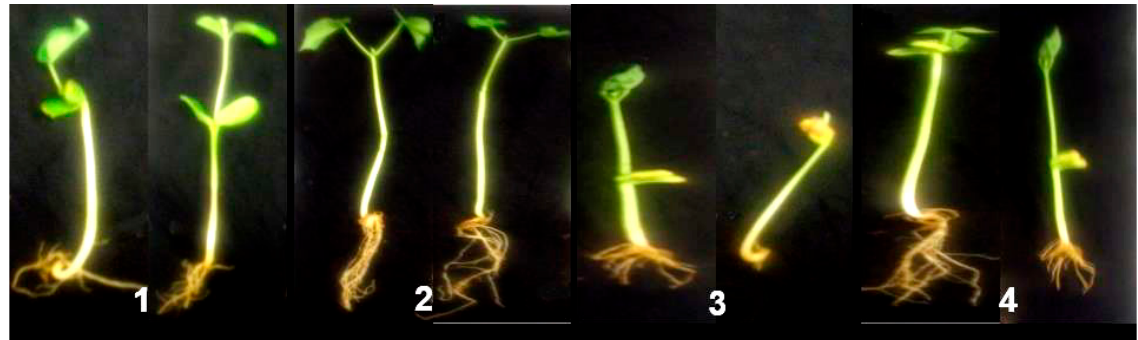
Figure 6. Growth of G. max seedling parameters: ( 1 ), uninfected seedlings (negative control); ( 2 ), seedlings cultivated with P. oligandrum (positive control); ( 3 ), seedling infested with P. aphanidermatum alone and ( 4 ), seedling infested with both P. oligandrum and P. aphanidermatum .